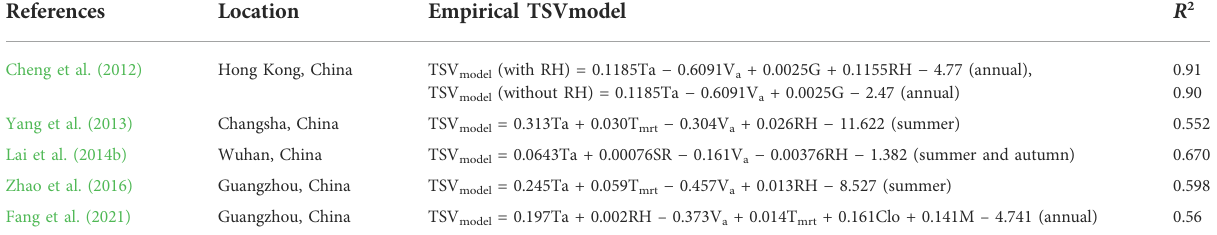
TABLE 2 Thermal comfort regression models in humid subtropical areas of China.